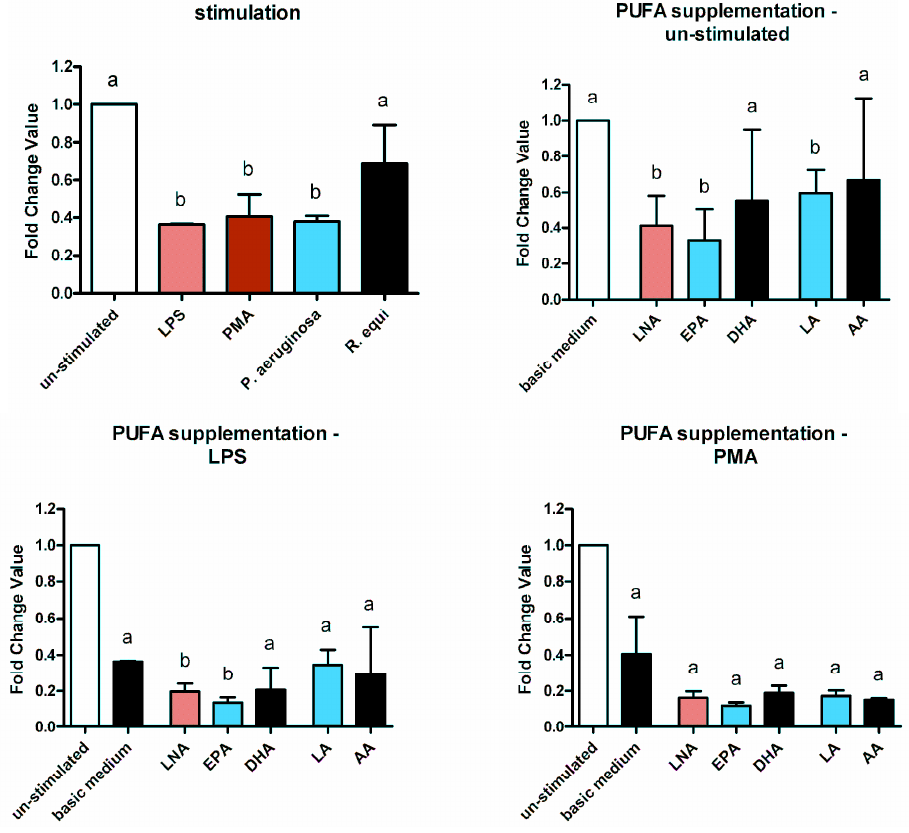
Figure 10. Expression of the lysozyme mRNA by RAW264.7 macrophages cultured in basic medium as well as in medium supplemented with 15 µmol/L alpha-linolenic acid (LNA), eicosapentaenoic acid (EPA), docosahexaenoic acid (DHA), linoleic acid (LA) or arachidonic acid (AA) after 24 h of stimulation with LPS, PMA, P. aeruginosa ATCC 10145 and R. equi ATCC 33701 respectively. Data are mean ± SD ( n = 6). Bars denoted by different letters are significantly